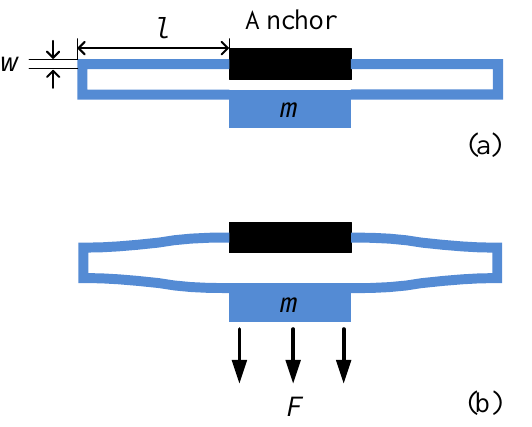
Figure 2. Structural diagram of a pair of folded support beams, in which m represents the mass of the sensitive mass block. ( a ) Dimensions of folded support beams; ( b ) deformation diagram of the folded support beams.